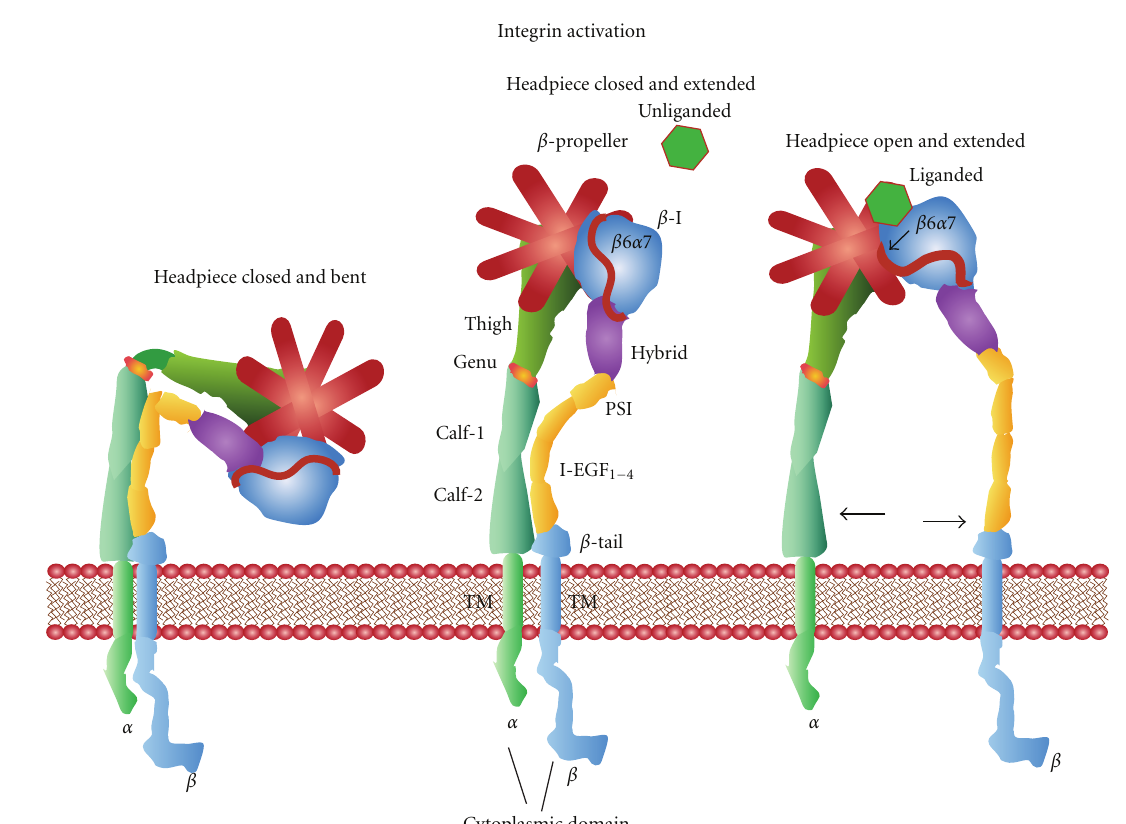
Figure 4: Integrins. Integrins are transmembrane glycoprotein adhesion receptor complexes consisting of α and β subunits. The α subunit contains a seven-bladed β -propeller head domain connected to a leg support structure made of a thigh, a calf-1, a calf-2, a transmembrane, and a cytoplasmic domain that mediates ligand specificity. The β subunit contains an N-terminal plexin-semaphorin-integrin (PSI) domain, a hybrid domain, a β -I domain, four cysteine-rich epidermal growth factor (EGF) repeats, a transmembrane, and a cytoplasmic domain that interacts with the cell cytoskeleton. The N-terminal β -I domain of a β subunit inserts into the β -propeller domain of an α subunit forming a headpiece complex. The formation of integrin receptor complexes depends on divalent cation (i.e., Ca 2+ , Mn 2+ , Mg 2+ ) that bind to metal-ion-dependent adhesion site (MIDAS) motifs in the α subunits and adjacent to MIDAS (ADMIDAS) motifs in β subunits. Three conformation states exist for α and β subunit complexes. (1) The unliganded conformation has a closed headpiece and a bent receptor structure with the EGF domains of the β -subunit touching the calf-1-calf-2 domains of the α -subunit. (2) The headpiece remains closed, but structural changes in the β -subunit EGF domains cause a separation from the calf-1-calf-2 domains of the α -subunits causing an extended structure. (3) Conformational changes in the β 6 - α 7 loops expose the ligand-binding site along with a complete separation of the β -subunit from the calf-1-calf-2 domains in the α -subunit. These conformational changes engage the specific integrin headpiece with its